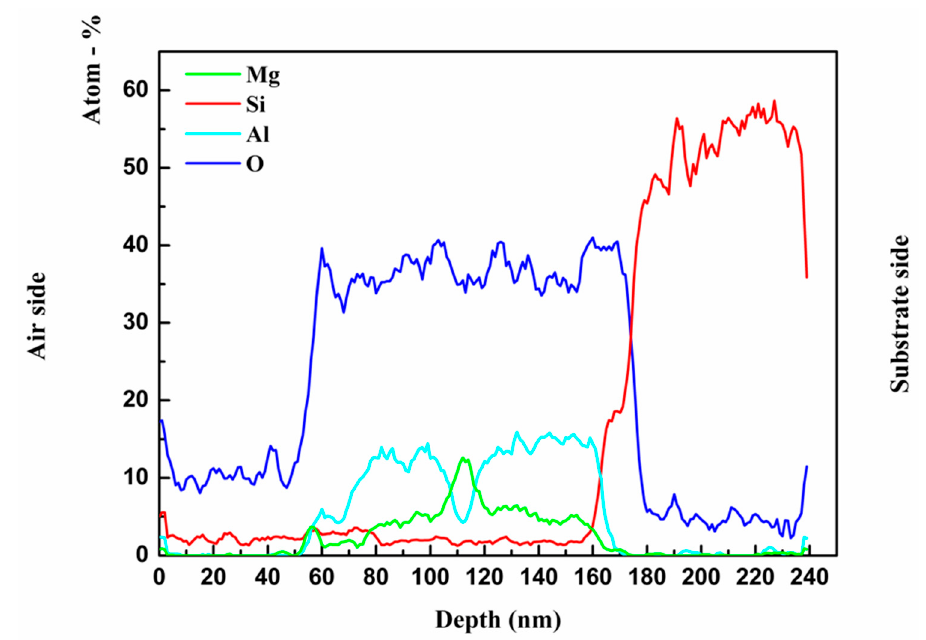
Figure 5. TEM EDS line scan of MgAl 2 O 4 /MgO with voids/MgAl 2 O 4 .